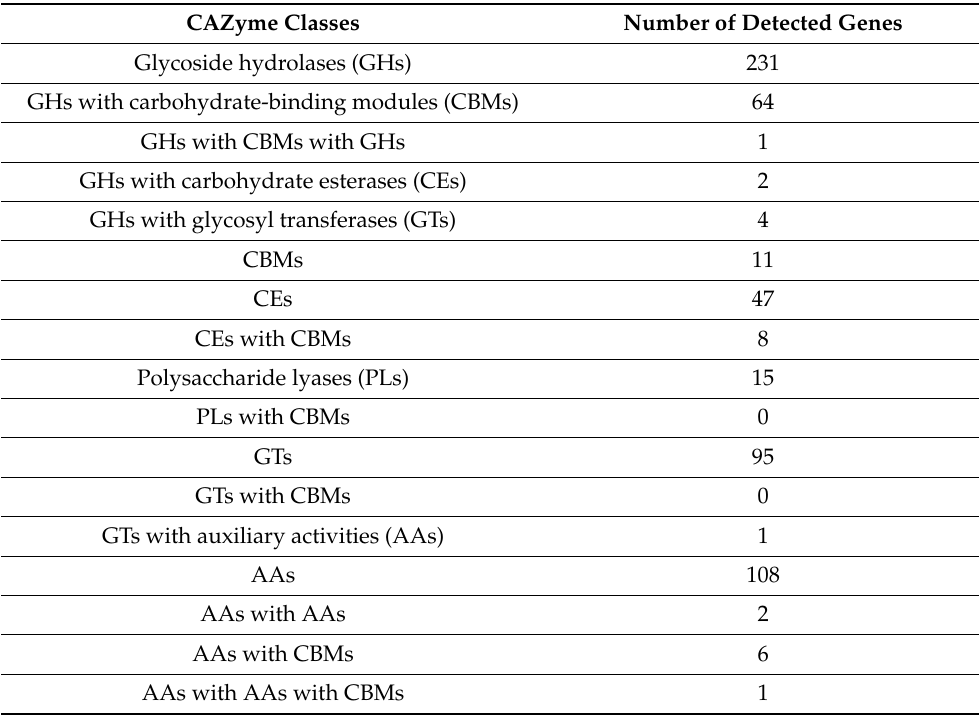
Table 1. CAZyme classes identified in the S. longicolleum FW57 genome annotation using DIAMOND, Hotpep, and HMMER searched on the dbCAN platform. CAZyme Classes Number of Detected